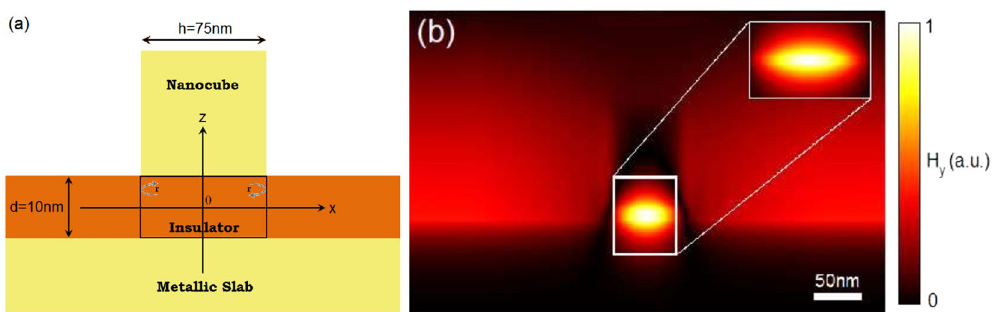
Figure 3. Cavity model. ( a ) Sketch representing the cavity model including the reflection coefficients of the gap-plasmon on the edges of the patch. ( b ) Map of the magnetic field (modulus) for a single 75 nm wide square patch, separated from the metallic film by a 10 nm thick dielectric layer with an optical index of 1.54 illuminated from above in normal incidence at resonance. The field profile in the region which is enclosed in the white rectangle is accurately predicted by the model (center). The inset shows the map of the magnetic field (modulus) as predicted by the cavity model when both excitation coefficients A l and A r are taken equal, at